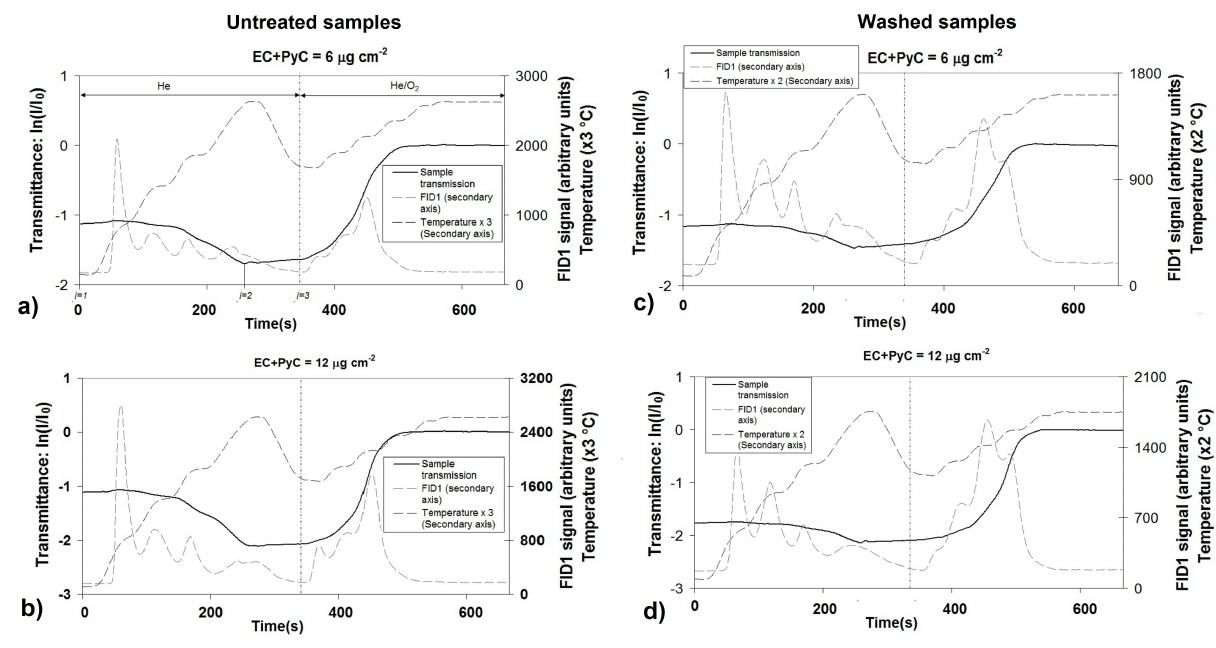
Fig. 4. Thermograms of untreated and washed sample for low ( a and c ) and high ( b and d ) loaded samples. In Fig. 4a, the beginning of the analysis ( j = 1), the point of minimum laser signal ( j = 2) and the switching point ( j = 3 and dashed vertical line) between the He and He/O 2 atmosphere are also